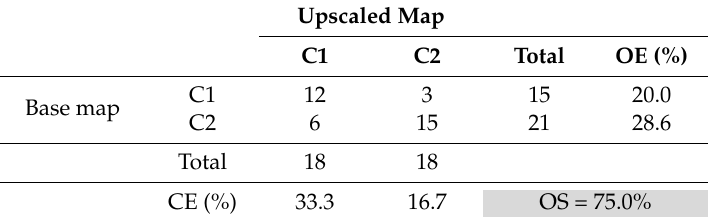
Table 3. Similarity matrix for the example in Figure 2. OS, OE, and CE represent overall similarity, omission error, and commission error,